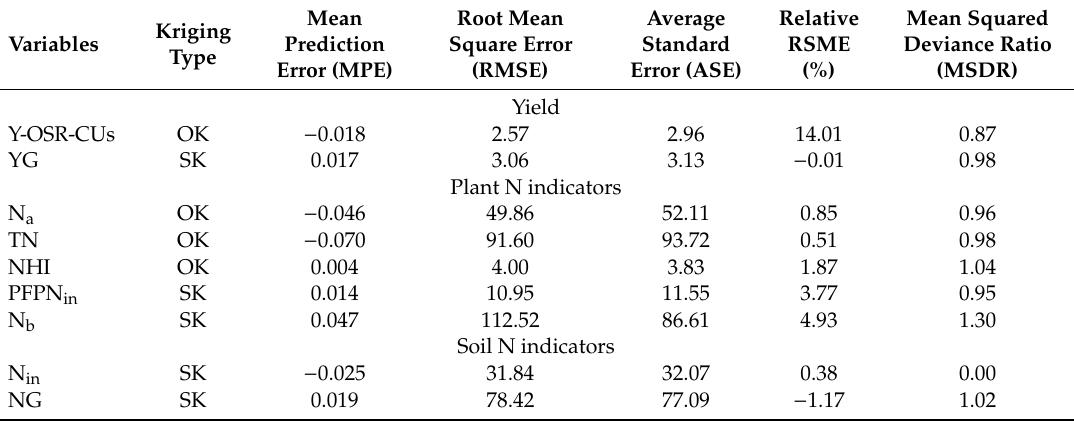
Table 6. Summary statistics of ordinary or simple